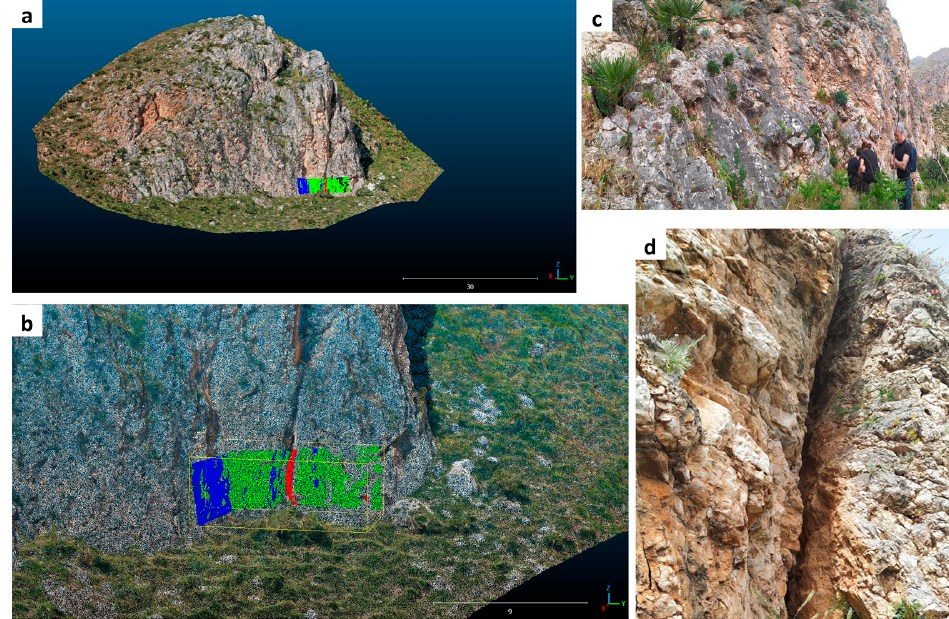
Figure 9. ( a ) The rock scarp and ( b ) details of the analyzed bounding box with discontinuity planes within each source sector colored according to each individuated discontinuity set. Green, blue, and red indicate ( c ) details of the scanline where the blue and green sets are mainly found and ( d ) details of the red set.